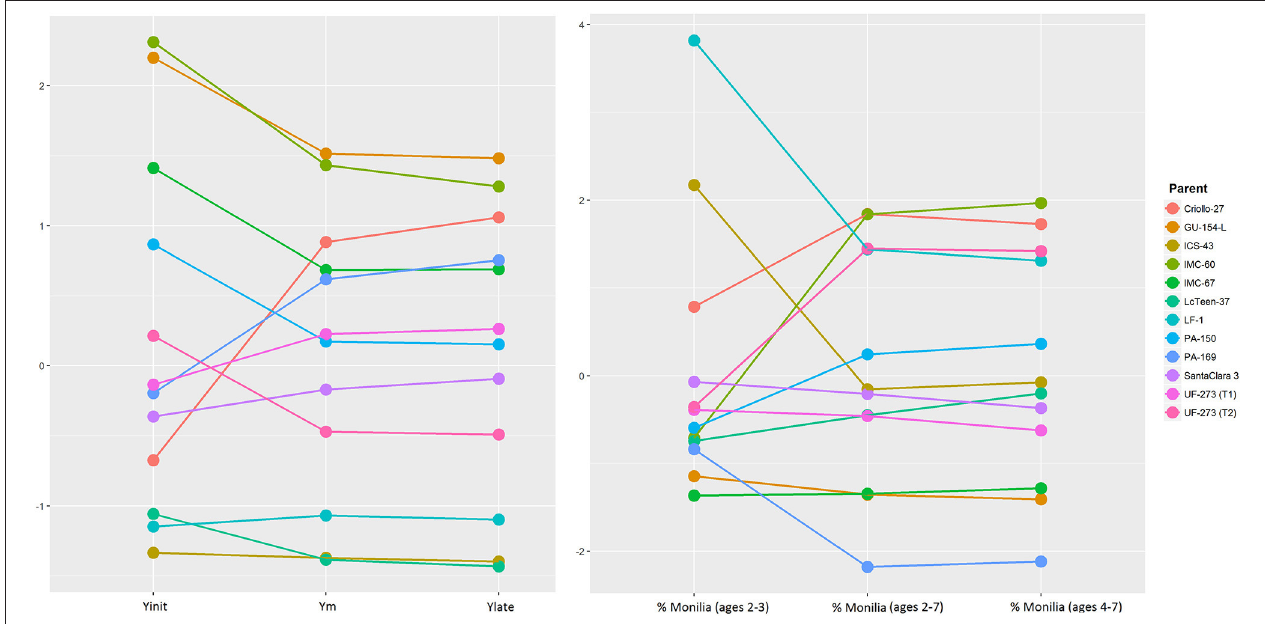
FIGURE 1 | Left : Predicted values, and changes in ranking for different measures of cocoa yield: initial mean yield for ages 2, 3 (Yint) mean yield for ages 2–7 (Ym) and late mean yield for ages 4–7 (Ylate). Right : Predicted values and changes in ranking for percentage of Monilia infected pods for the same time points as yield. Further details of these traits are presented in Table 1